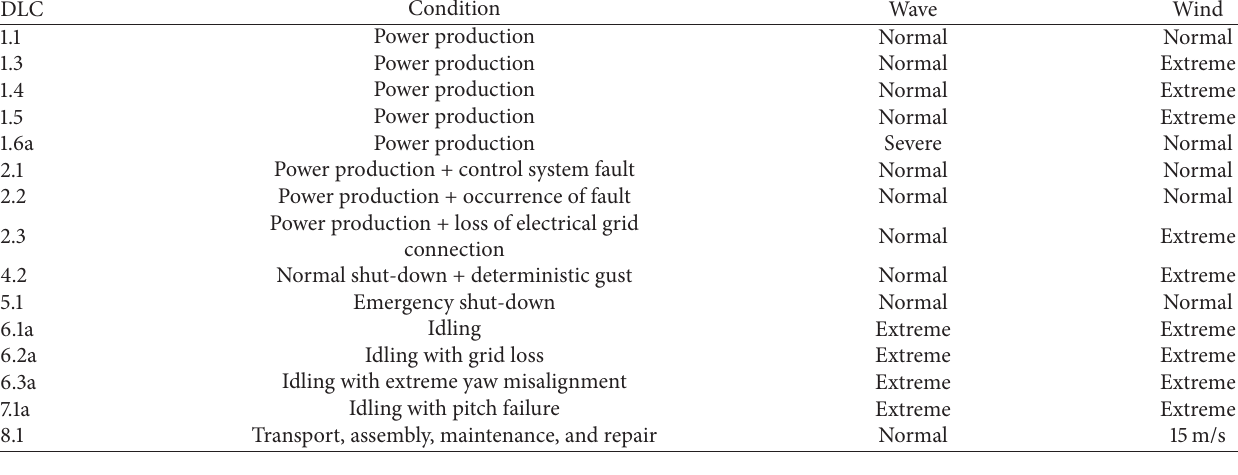
Table 4: Design load cases (DLC) for ultimate limit state.